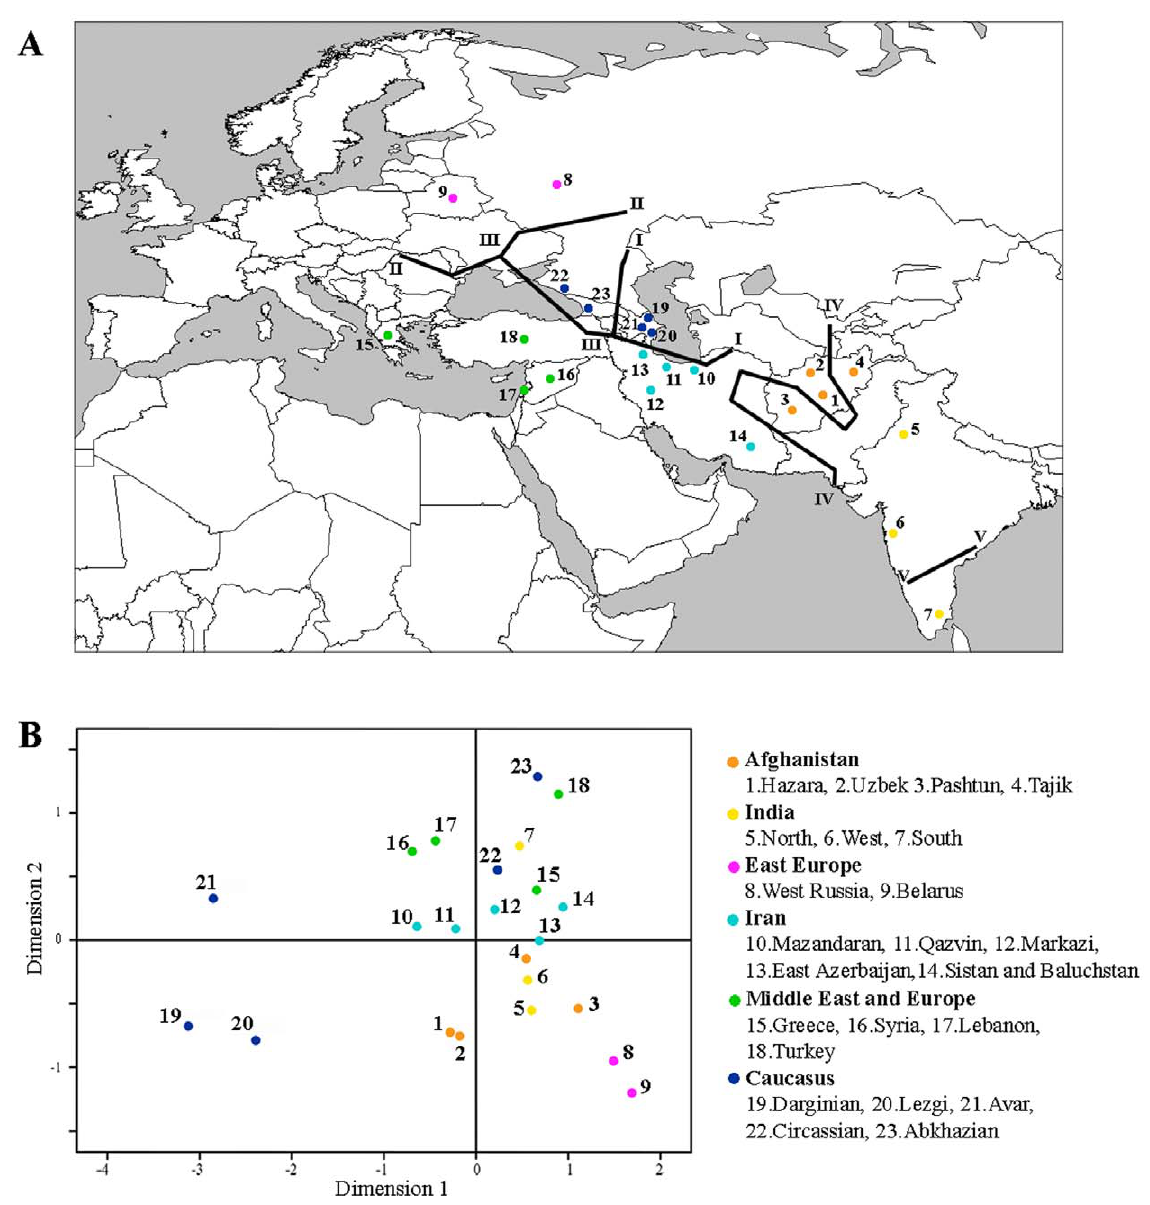
Figure 2. Population genetic structure vs geography. Genetic barriers (A) and MDS plot (B) based on the W ST ’s distances between populations derived from Y-STR